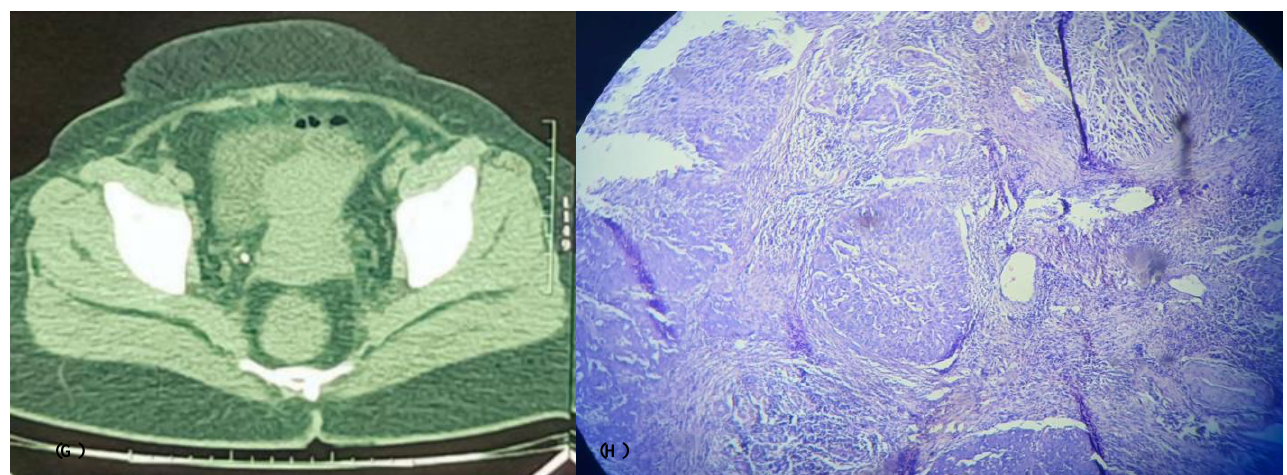
Fig. 5. (A) Carcinoma of the cervix, (B) Endocervical polyp, (C) Endocervicitis, (D) The histopathological appearance of adenocarcinoma of the endometrium, (E) Endometrial hyperplasia, (F) Atrophic endometrium, (G) Carcinoma cervix infiltrating bladder base, (H) Histopathological appearance of carcinoma